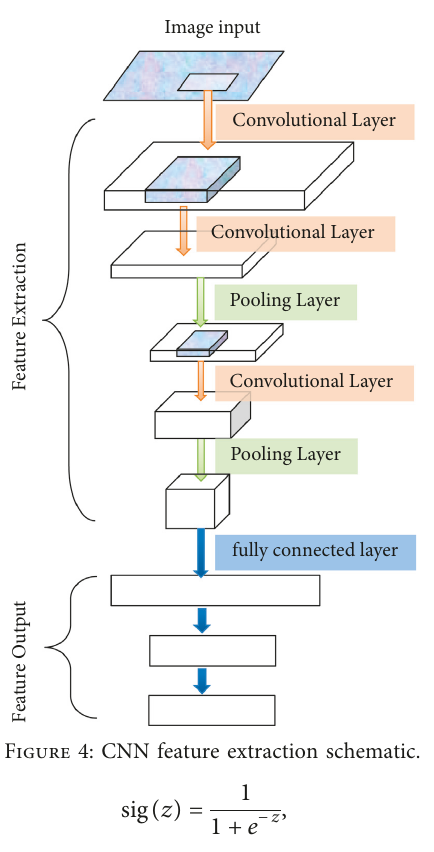
Figure 4: CNN feature extraction